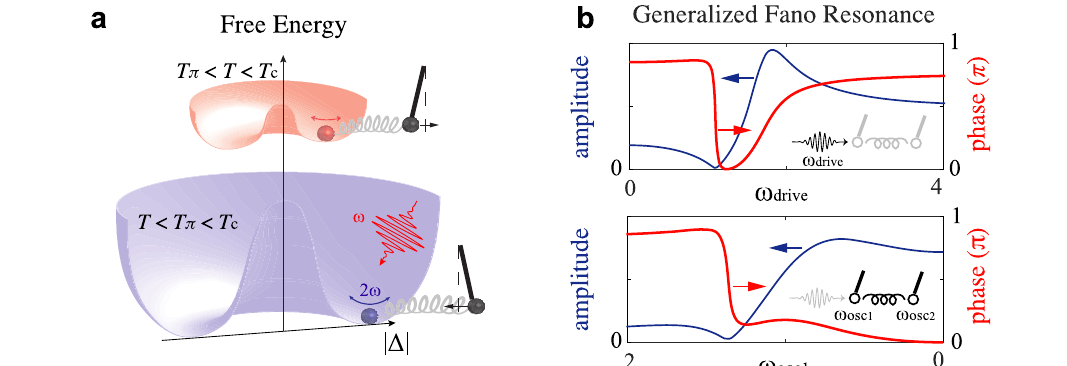
experimentthedrivingfrequencyis fi xed,buttheresonancefrequencyofoscillator 1 ( ω osc1 ) is swept. Here, oscillator 1 represents the superconducting fl uctuations, whose energy scale isa function of temperature. By sweeping temperature from 0 towards T c , the energy of the superconducting fl uctuations decreases from max- imum to zero. We chose the direction of the ω osc1 axis as shown so that it corre- sponds to a temperature axis that increases to the right. Note, however, that sweeping temperature is not entirely equivalent to sweeping driving frequency, as additional parameters like the damping constant may depend on temperature. Details of the generalized Fano resonance model can be found in Supplementary Materials